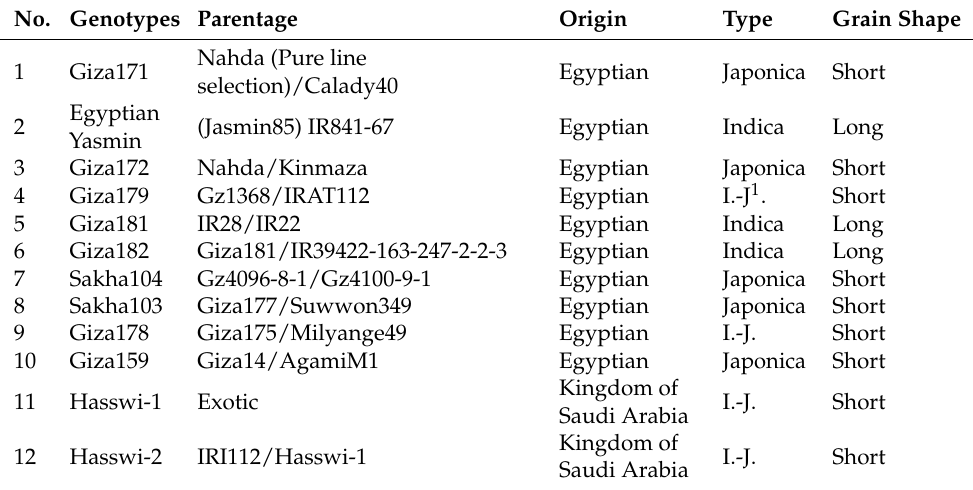
Table 1. List of rice genotypes used in phenotyping and DNA